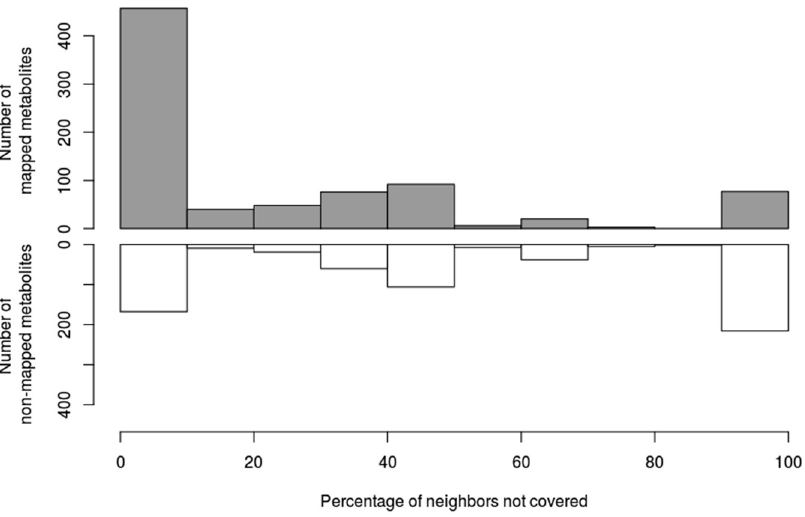
Figure 5. Relative coverage of metabolites’ neighborhood. Metabolites are categorized according to the coverage of their neighborhood, from fully covered to 90–100% uncovered. The Y -axis represents the number of metabolites in each category, with mapped metabolites displayed in grey, and non-mapped metabolites displayed in white.